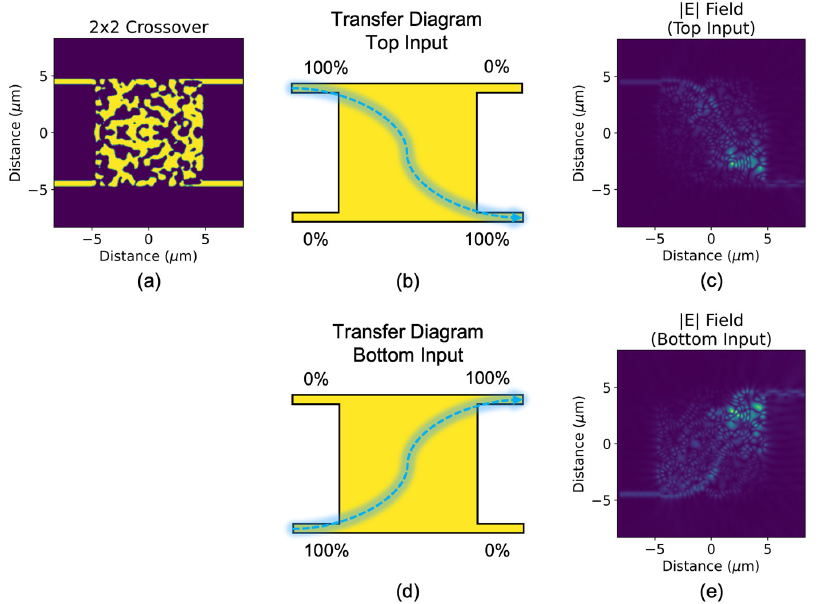
Figure 3. ( a ) Topologically optimized 2 × 2 3-dB crossover and its transfer diagrams for the following initial conditions: ( b ) input at the top waveguide, ( d ) input at the bottom waveguide. Top-view optical field profiles of ( b , d ) are shown in ( c , e ), respectively.